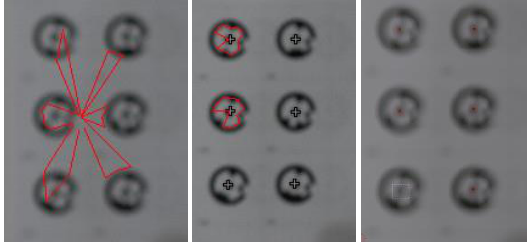
Figure 4. Automated target detection gradually failing with aperture (a) six targets simultaneously (f/2.2). (b) complete target including code (f/3.5). (c) just centre target dot (f/2.0).